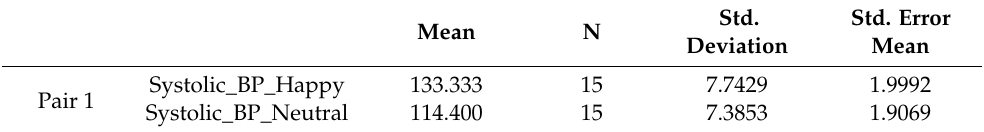
Table 5. Paired samples statistics for systolic BP (happy to neutral state).